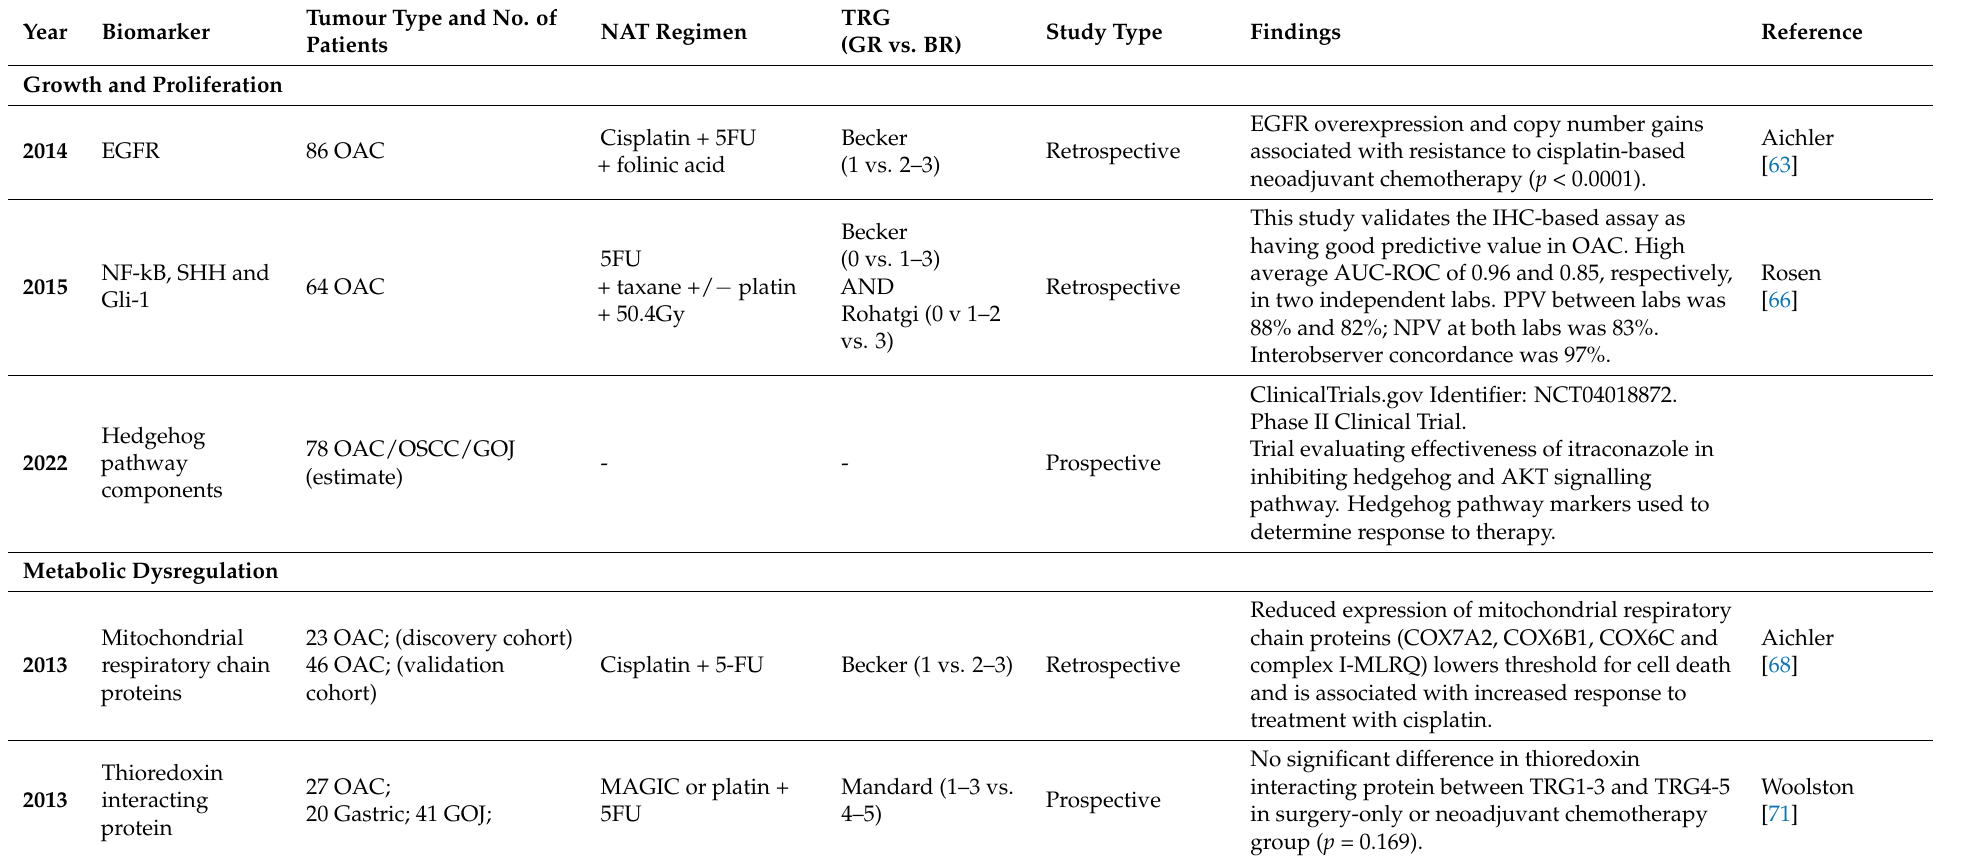
Table A4. Protein